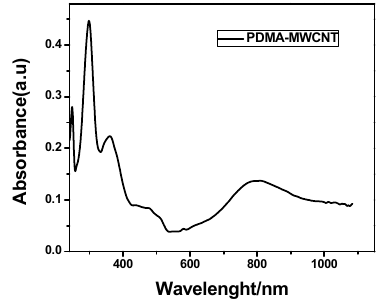
Figure 3. UV-visible absorption spectrum of PDMA-containing MWCNT in dimethylsulphoxide (DMSO).